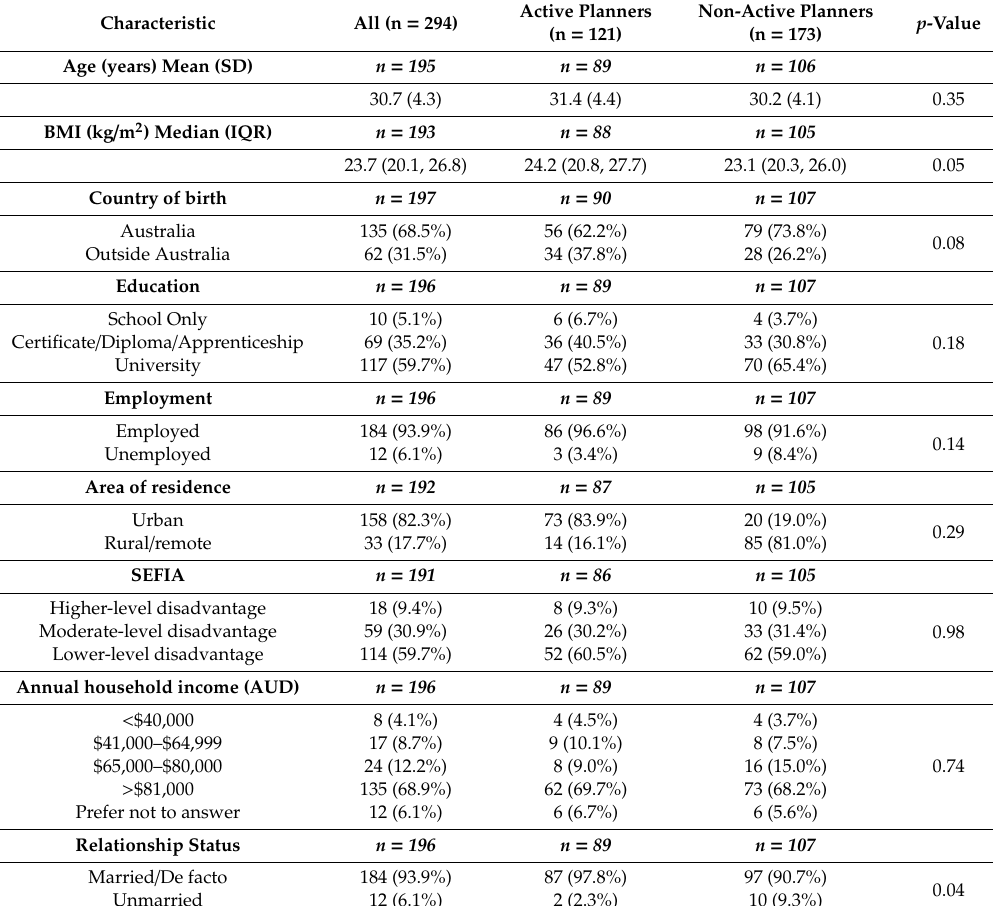
Table 1. Participant characteristics stratified by pregnancy